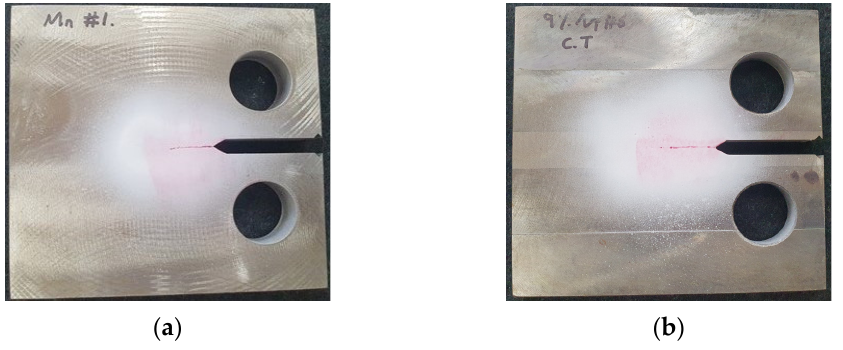
Figure 13. FCGR test specimens for weld metals: ( a ) high Mn; ( b ) 9% Ni.